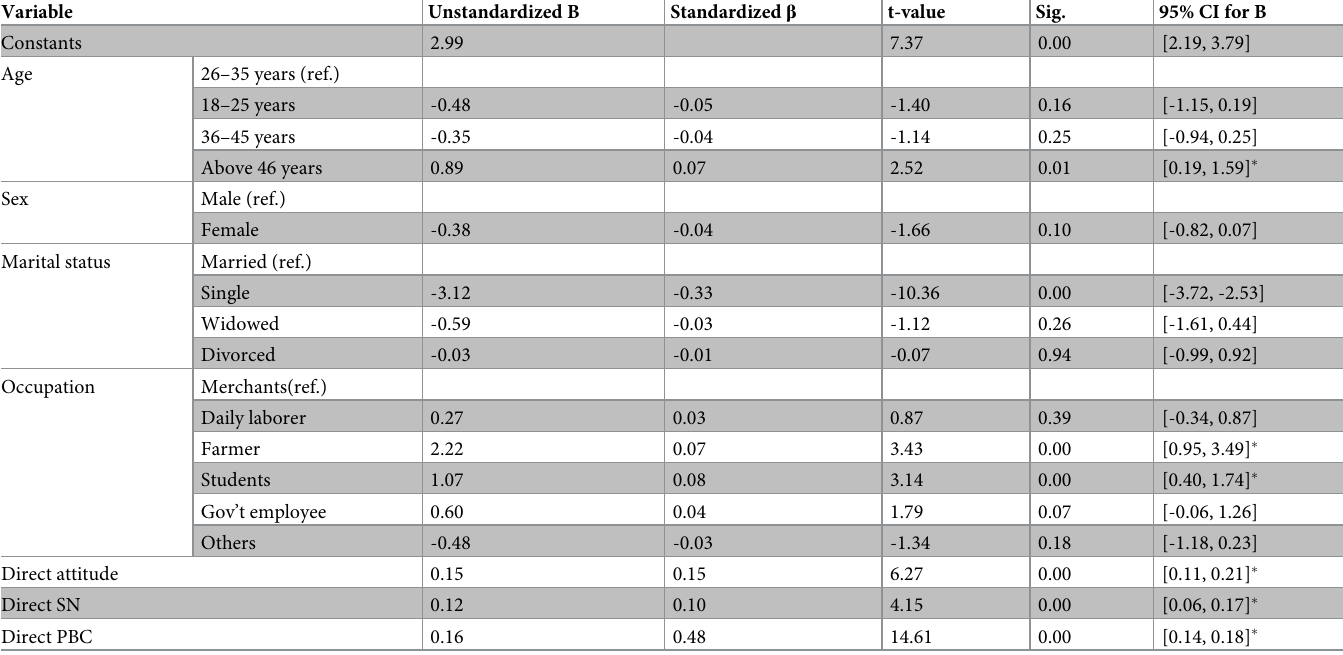
Table 3. Multiple linear regression of intention to solid waste management practice and its predictors among households of Butajira town, Southern Ethiopia, 2020 (N =